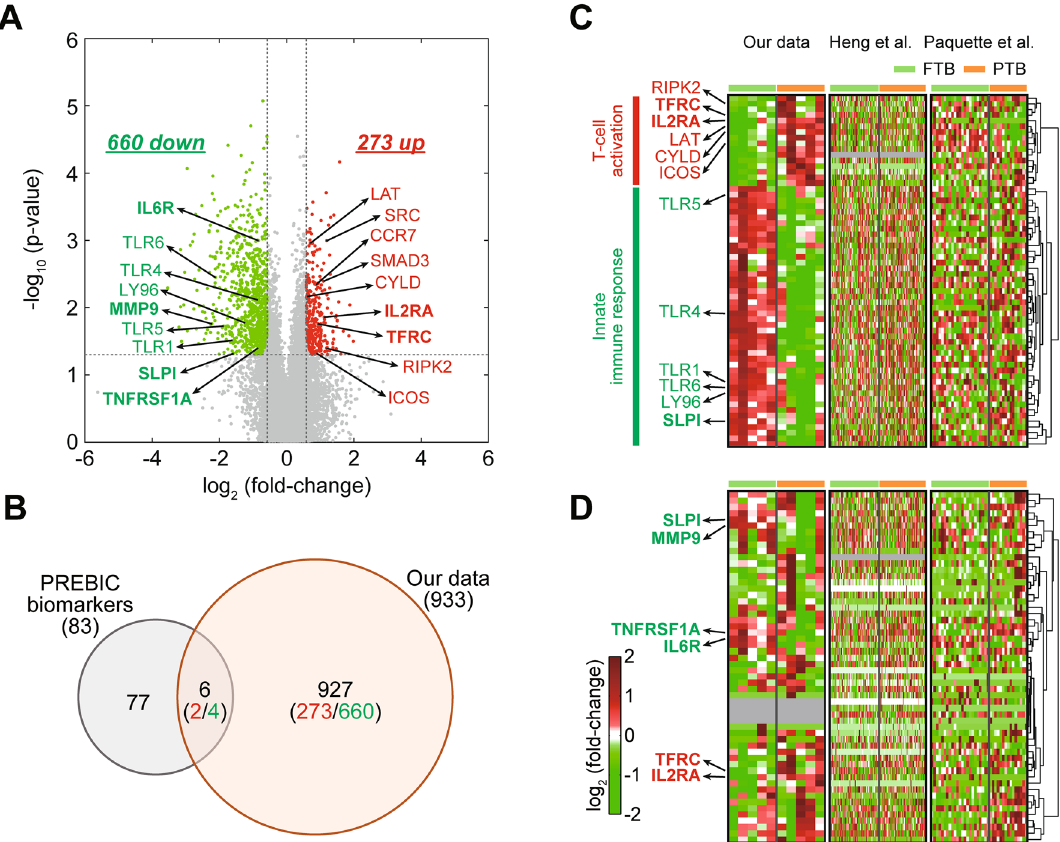
Figure 1. Differentially expressed genes (DEGs) between PTB (preterm birth) and FTB (full-term birth) groups. ( A ) Volcano plot for the comparison of PTB with FTB. Dotted lines represent the cutoffs for log 2 -fold- change and adjusted p value. Red and green dots denote the 273 upregulated and 660 downregulated genes, respectively. The representative up- and downregulated genes involved in T-cell activation (red) and innate immune response (green), respectively, are indicated by arrows. The six genes that overlapped with the 83 PREBIC PTB predictors are highlighted in bold. ( B ) Venn diagram showing the relationship between the DEGs and the PREBIC PTB predictors. Numbers of upregulated (red) and downregulated (green) genes in the sections of the Venn diagram are shown. ( C , D ) Heat maps showing expression changes of up or downregulated genes involved in T-cell activation and innate immune response, respectively and the 56 genes expressed ( C ) in at least one dataset ( D ) in all the three datasets. The color bar represents the gradient of log 2 -fold-change of mRNA expression levels in the samples with respect to the median mRNA expression